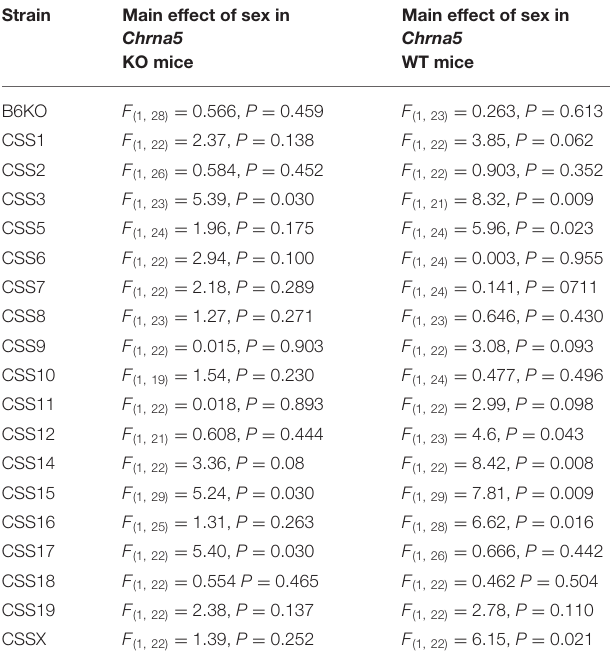
TABLE 2 | Within Chrna5 genotype analysis of sex